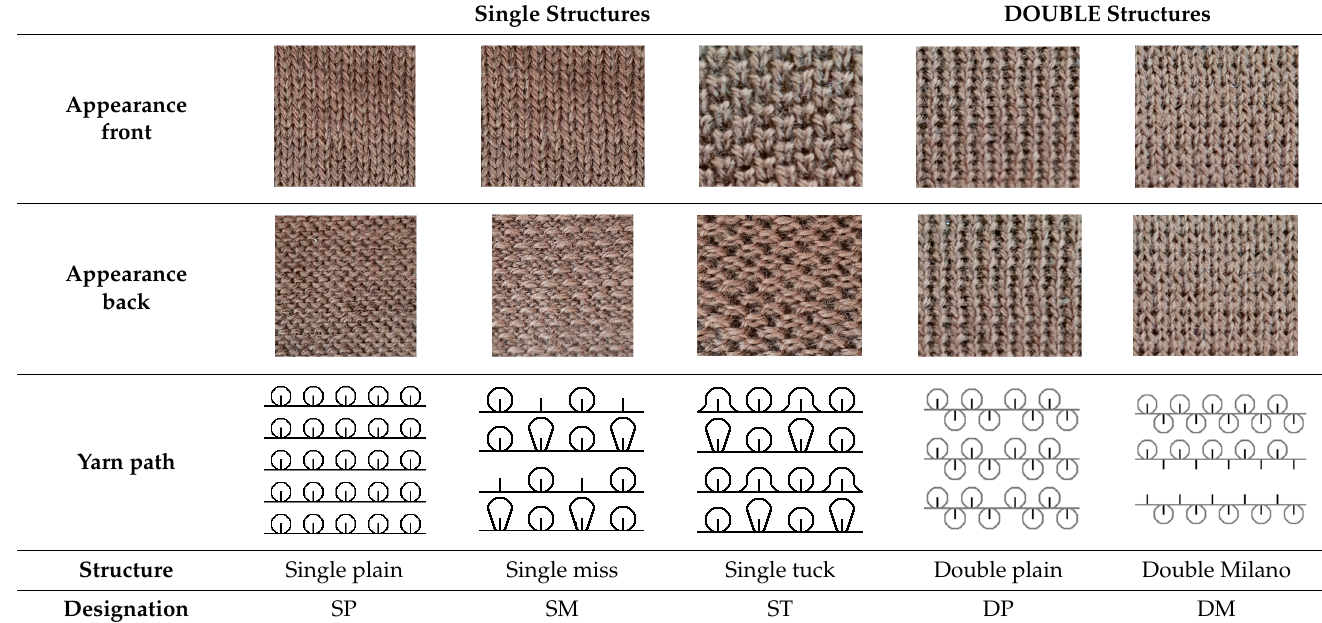
Table 2. Yarn designation and characteristics.